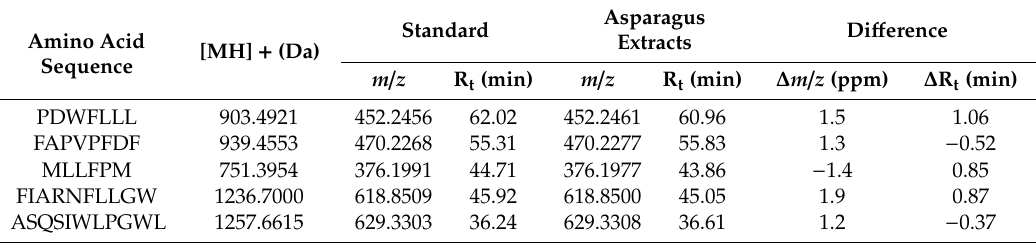
Table 2. Sequences of the five synthetized bioactive peptides with the corresponding observed [MH] + , m / z values and retention times (Rt) for the standard peptides and for the asparagus by-product sample. The di ff erence between the standard peptide and the asparagus by-product peptides is also